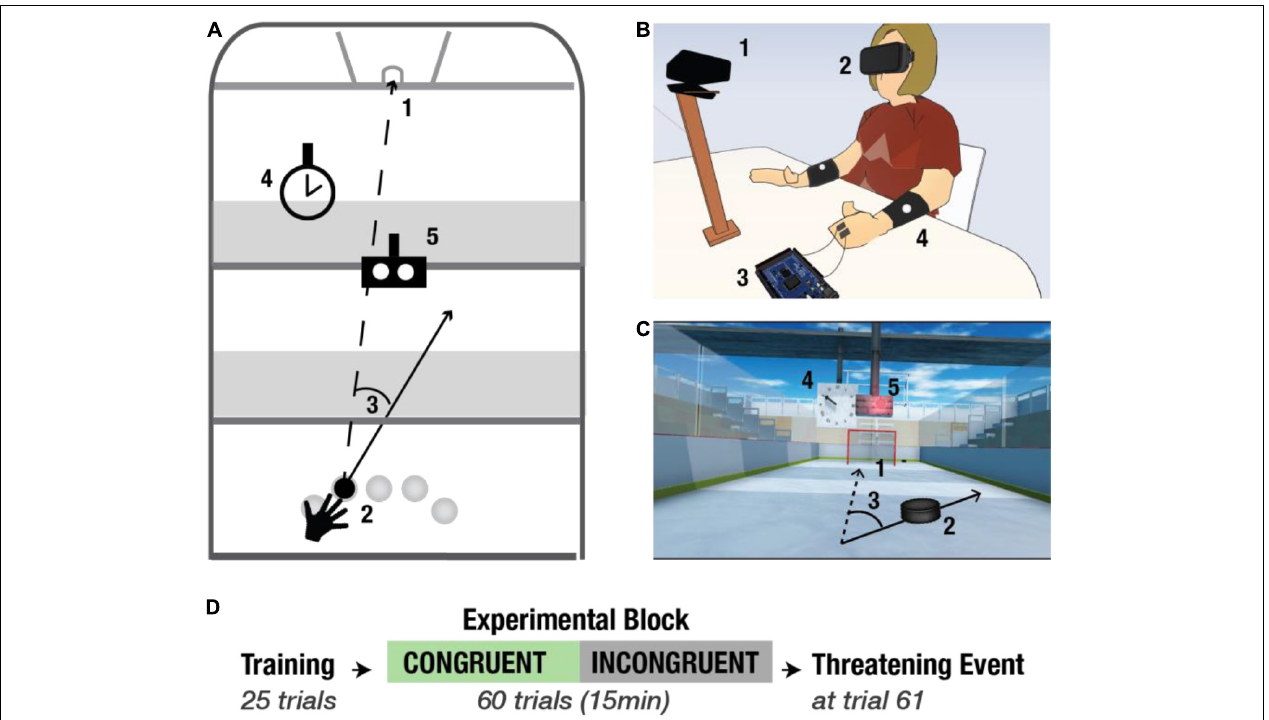
FIGURE 1 | Experimental setup and protocol. (A) Schematic bird view of the virtual environment. 1- goal; 2- five starting positions; 3- an example of a directional error; 4- a clock; 5- the Go Signal (GS). (B) Experimental setup. 1- motion tracking device (Kinect); 2- Head Mounted Display (HMD, HTC-Vive Headset); 3- Arduino and E-Health; 4- Bracelets with reflecting markers for the tracking. (C) Virtual scene. The first-person perspective view of the scene. (D) Experimental protocol. All participants go through the Training Block (TB) (25 trials). Then they are randomly split into two experimental conditions: congruent (congruent condition, green arrow) or incongruent (incongruent condition, black arrow), and both groups undergo the Experimental Block (EB). At the end of the experiment, all the participants experience the Threatening